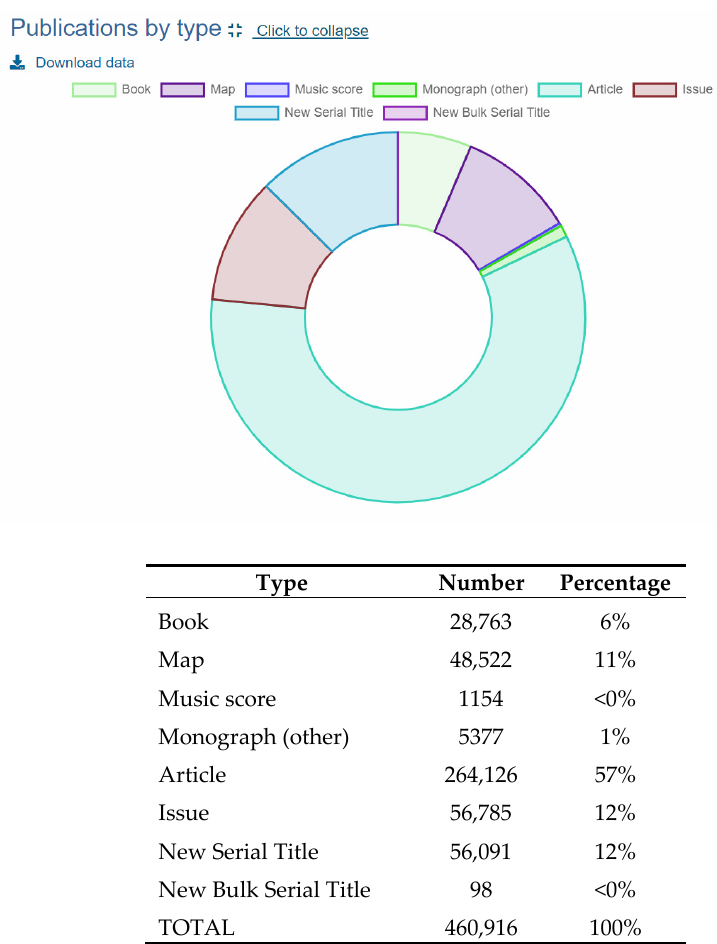
Figure 3. Reporting dashboard in NED portal.